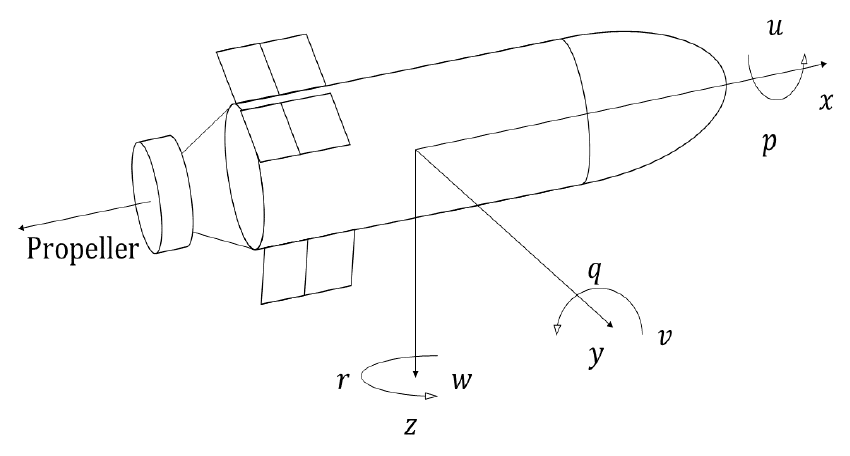
Figure 1. The UUV